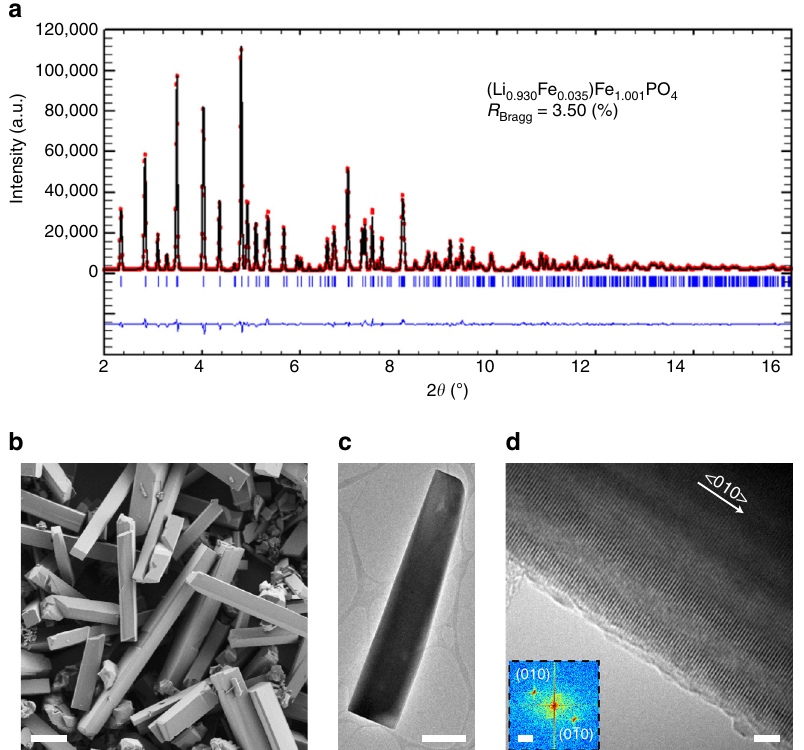
Fig. 1 Structural characterizations of the LiFePO 4 microrod sample. a High-resolution PXRD of the LFP microrods and the Rietveld-re fi ned pattern using the Fe-rich model ( λ = 0.2128 Å). b SEM image of the LiFePO 4 microrods. The scale bar is 10 μ m. c Low-magni fi cation TEM image of a single LiFePO 4 microrod. The scale bar is 1 μ m. d High-resolution TEM image of a representative LiFePO 4 microrod, showing that the microrod is a single crystal with the long-axis direction along < 010 > . Inset is the corresponding FFT con fi rming that the observed lattice planes are (010) family of planes. The scale bars are 5 nm and 2 nm − 1 ,